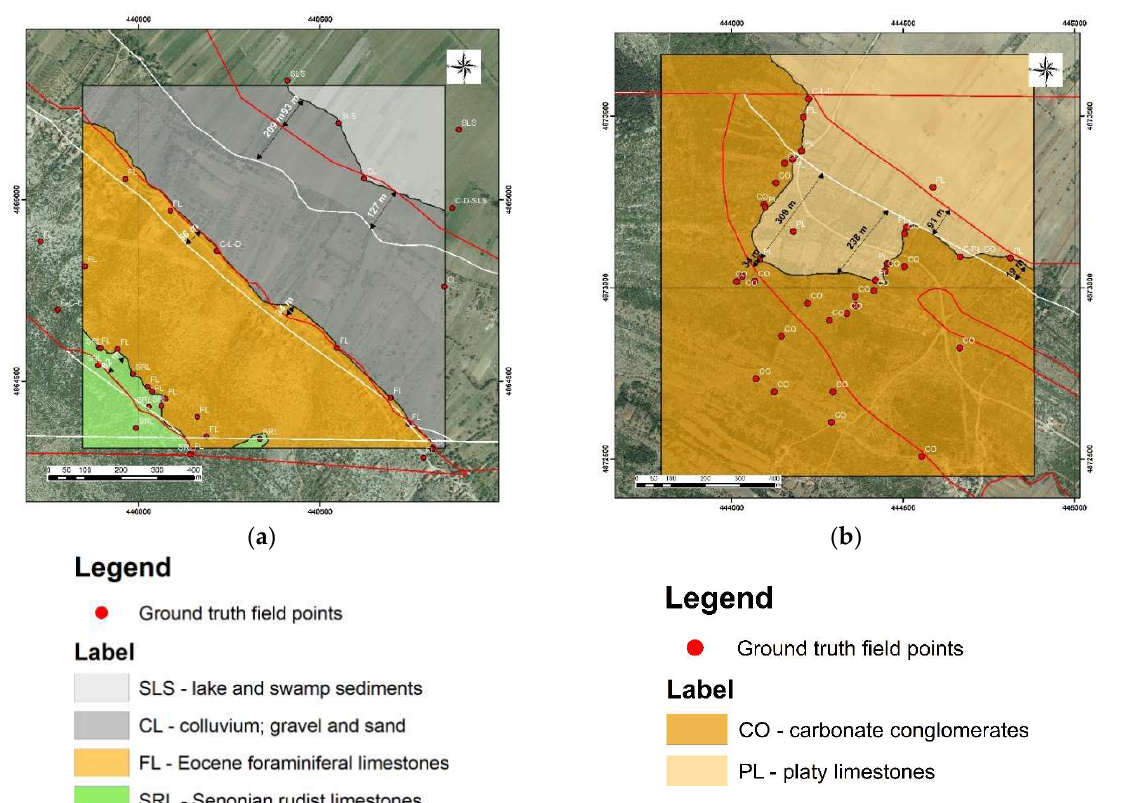
Figure 2. ( a ) Lithological map of Subset 1; ( b ) lithological map of Subset 2. Black lines on both images are GBs derived from field mapping during December 2021. Red lines are GBs derived by ML algorithms. White lines are GBs from the original map. Differences in GB geometry were measured, and, at these sites, it amounted to between 30 m and 300 m.